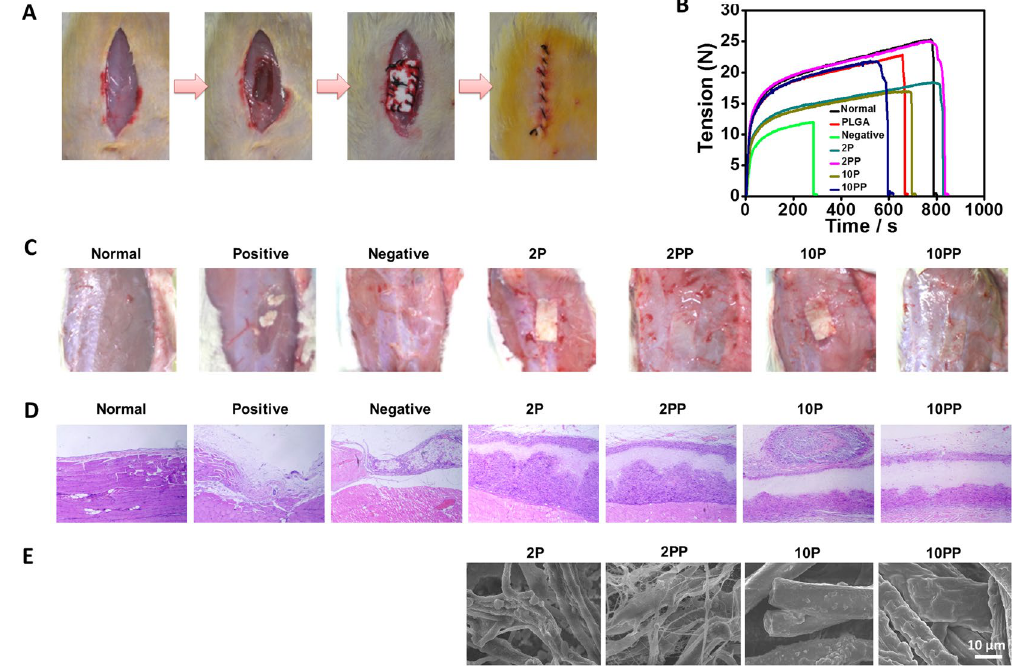
Figure 3. Functionalized electrospun PCL memberanes were effective for the regenerating muscle injury. ( A ) Diagram of PCL fibrous membranes implantation in vivo . After implantation into rat muscles for 40 days, mechanical properties of PCL fibrous membranes ( B ), visible morphology ( C ) and histological observations ( D ) of muscles and SEM images of PCL fibrous membranes ( E ) were